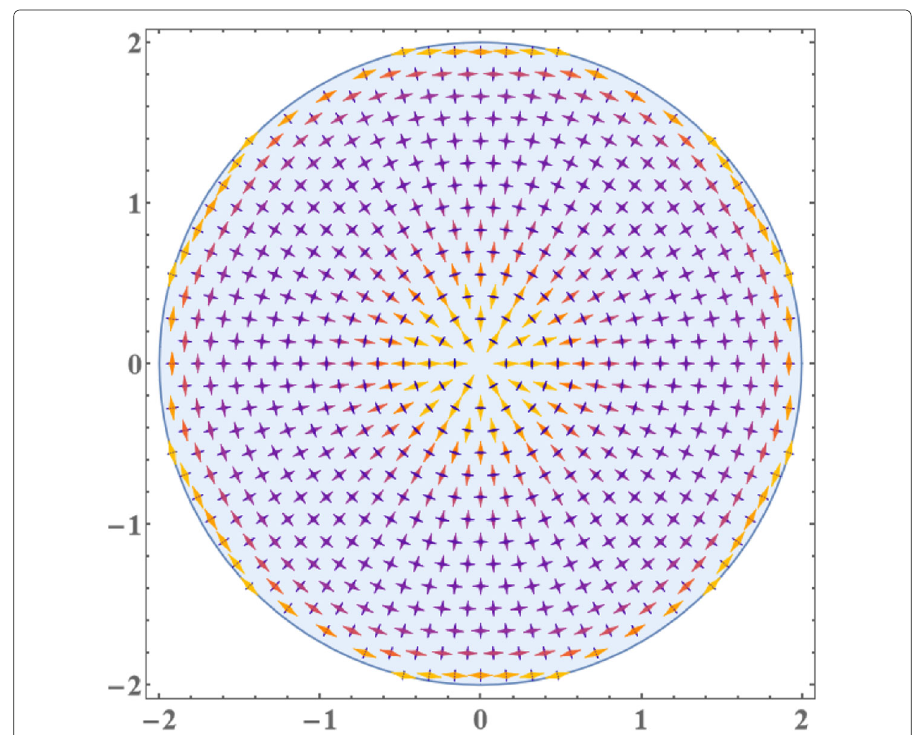
Fig. 6 The correlation field of the alignment tensor D ( 0,2 ) ( r ) in a homogeneous distribution of loops with radius R = 1 visualized by two fields of double arrows in eigenvector directions. Length and color of the arrows indicate the magnitude of the vectors,